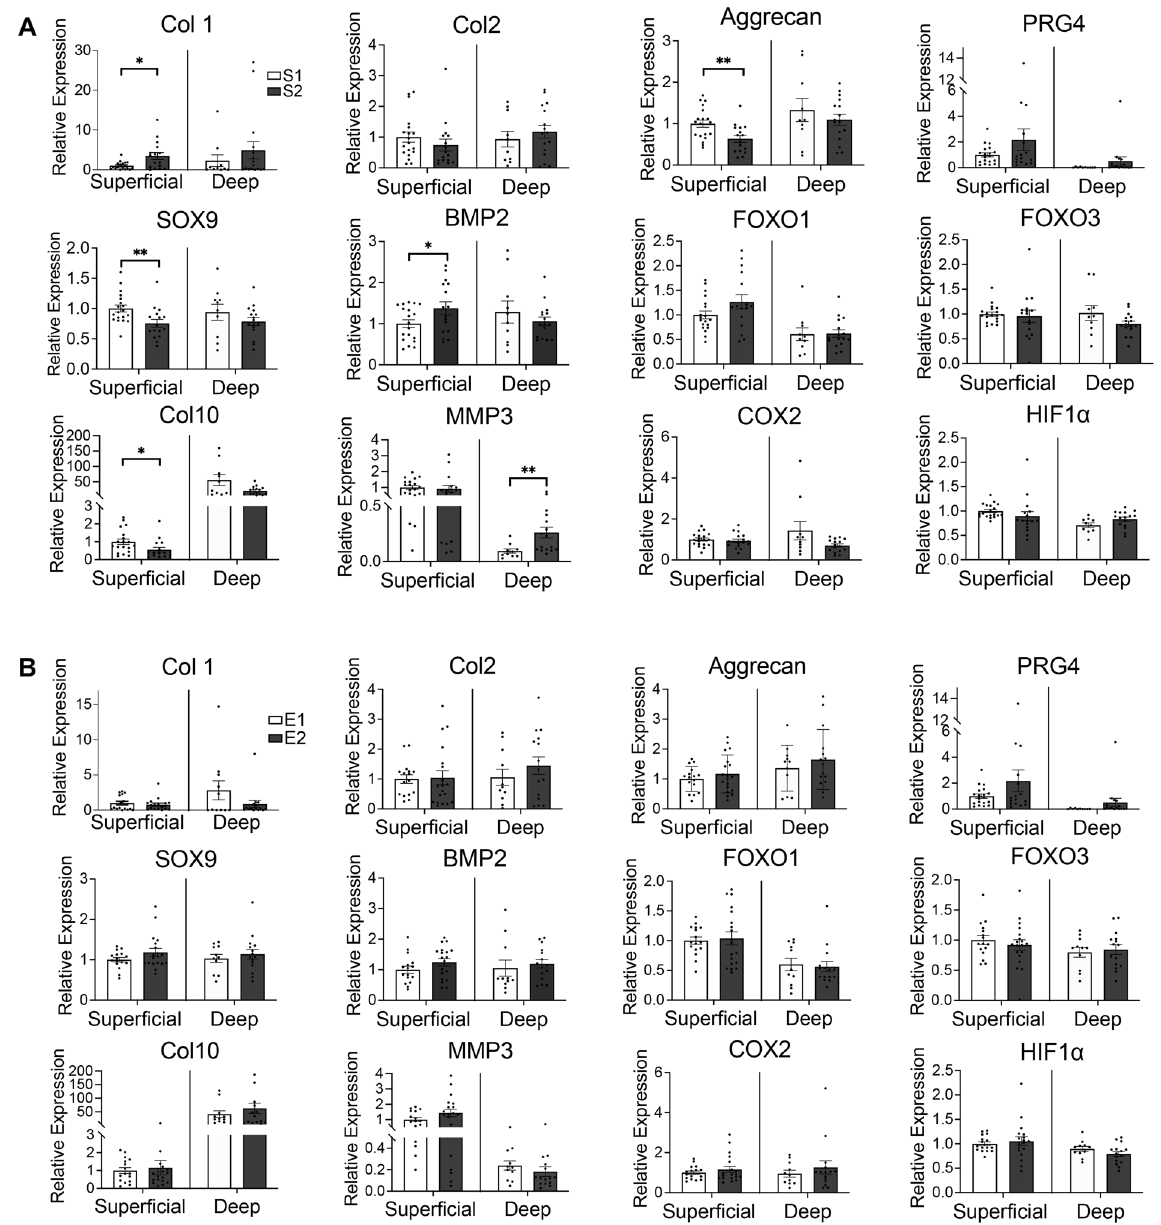
Figure 4. Relationship between ultrasound grade and OA-related gene expression in the articular cartilage. ( A ) Comparison between ultrasound S1 and S2 grades. ( B ) Comparison between ultrasound E1 and E2 grades. Bars are show the mean ± SEM. * p < 0.05, ** p <